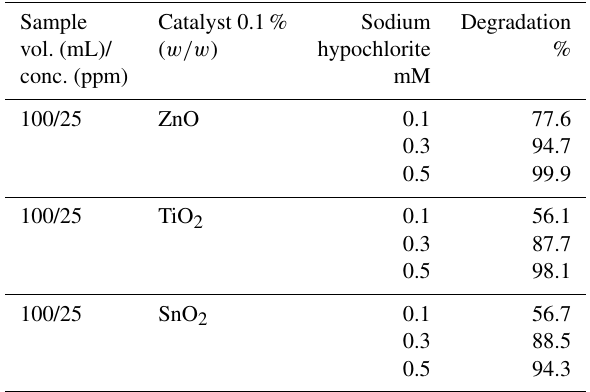
Figure 9. The efficiency of the BPA degradation by different doses of NaOCl in suspensions of ZnO. Table 1. The effect of different oxidant concentration on the pho- todegradation of BPA within 1h of irradiation.